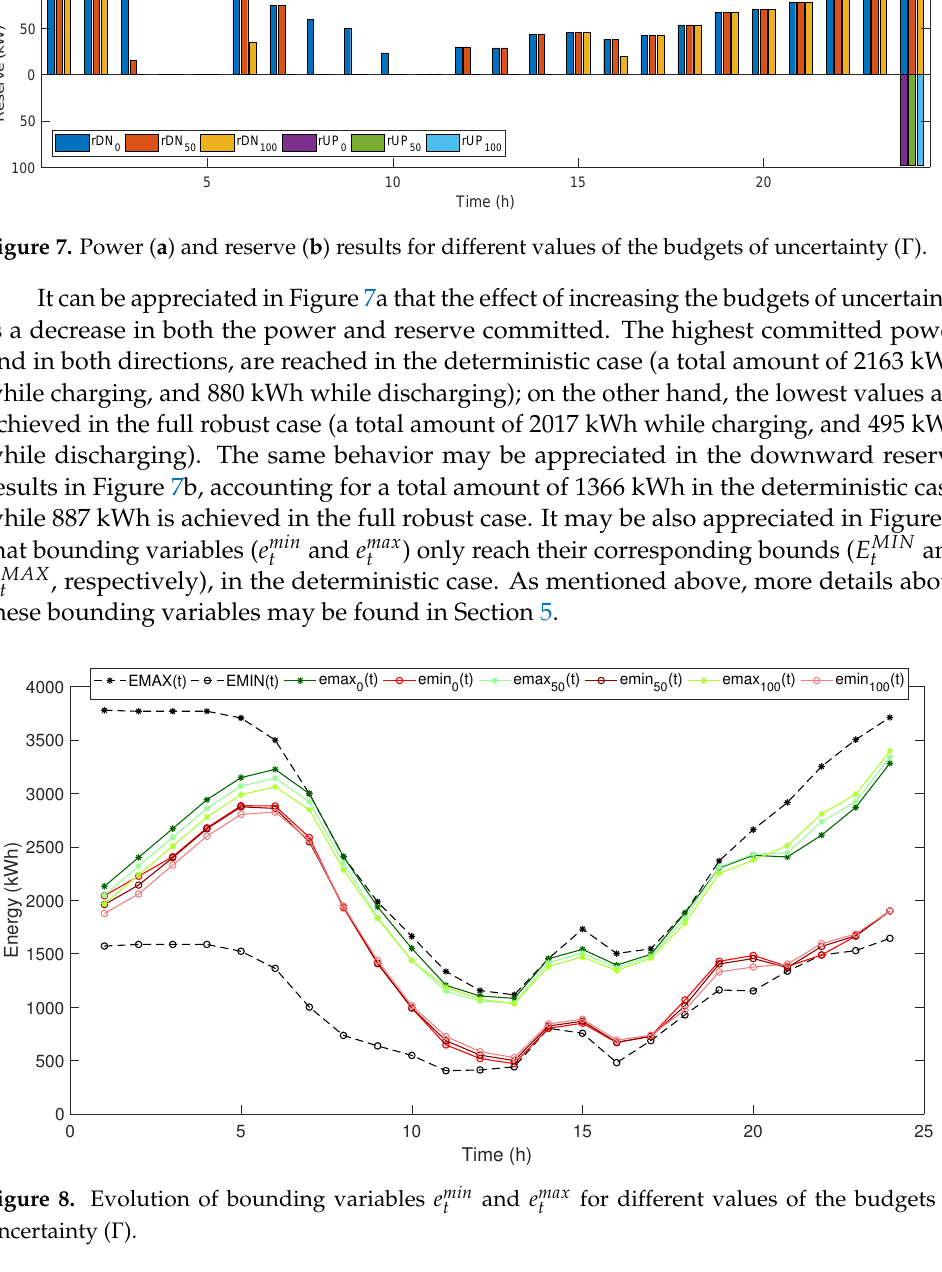
and e max for different values of the budgets of t t